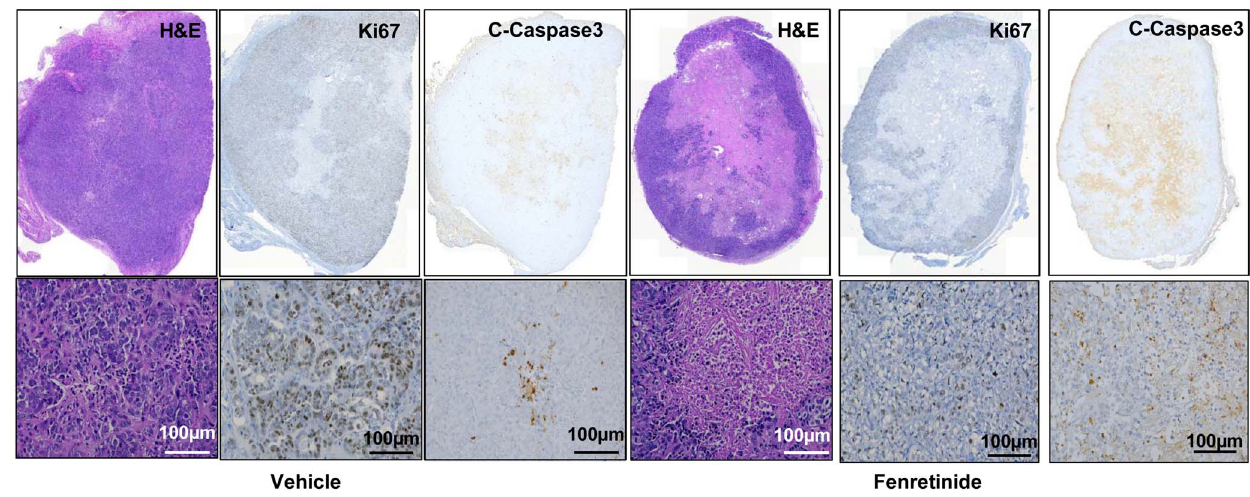
Figure 6. Inhibition of cell proliferation and increase in apoptosis following fenretinide treatment. Excised tumors were fixed in formalin, paraffin embedded and sectioned. ( A ) H & E staining and immunohistochemical staining with anti-Ki67 antibody (proliferation marker) and anti-cleaved caspase -3 (apoptosis marker) of whole sections of tumor xenografts. ( B ) The images are at 100 m m.